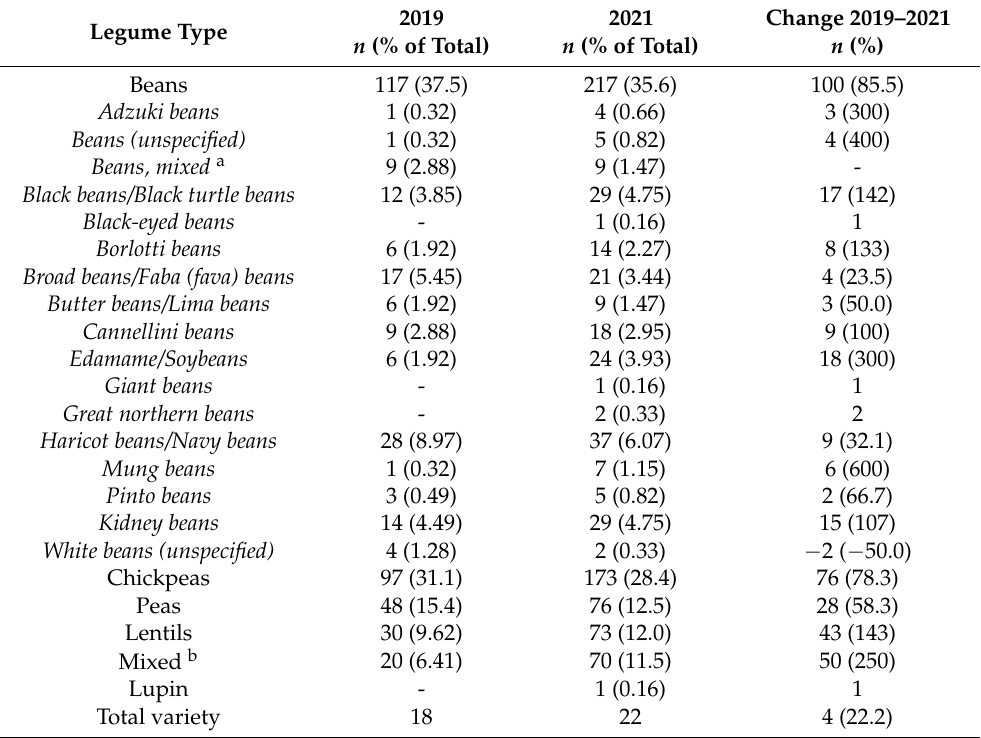
Table 3. Legumes varieties used in legume products in 2019 and 2021 and the change in number of products over